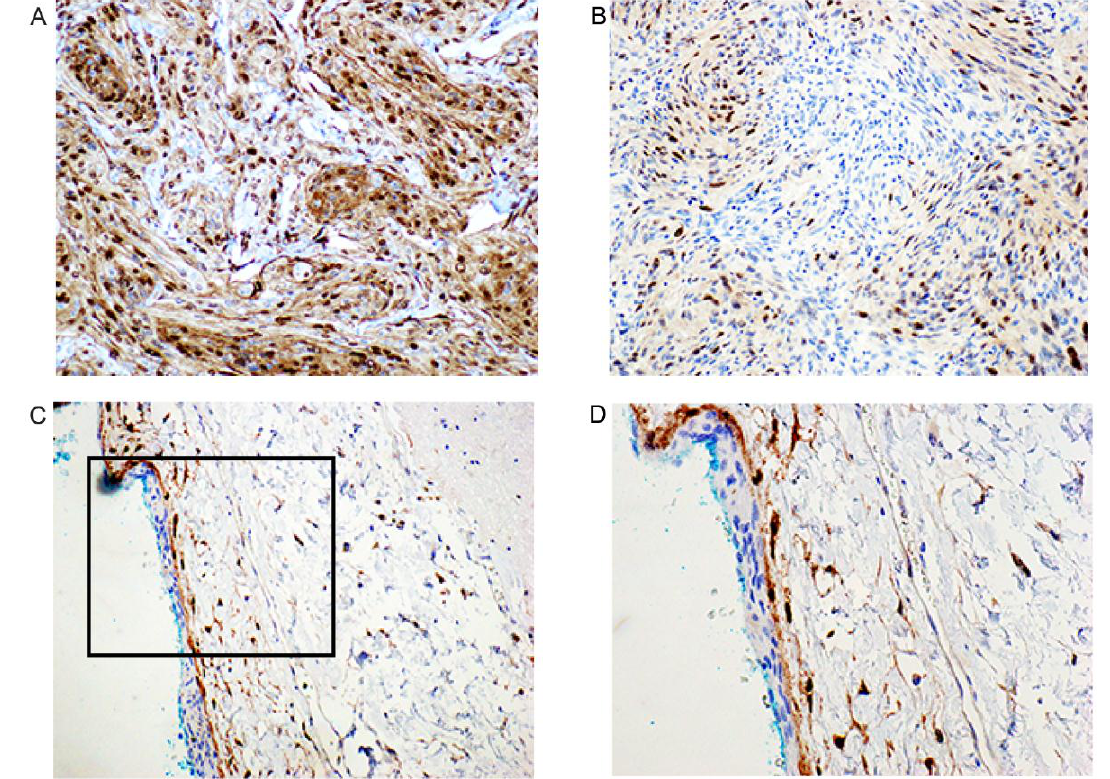
Figure 4. Immunohistochemistry of Cyclin D1 ( A – D ) in meningioma ( A – B ) compared to normal arachnoid membranes ( C – D ). ( A ) Meningioma with strong nuclear signal of Cyclin D1